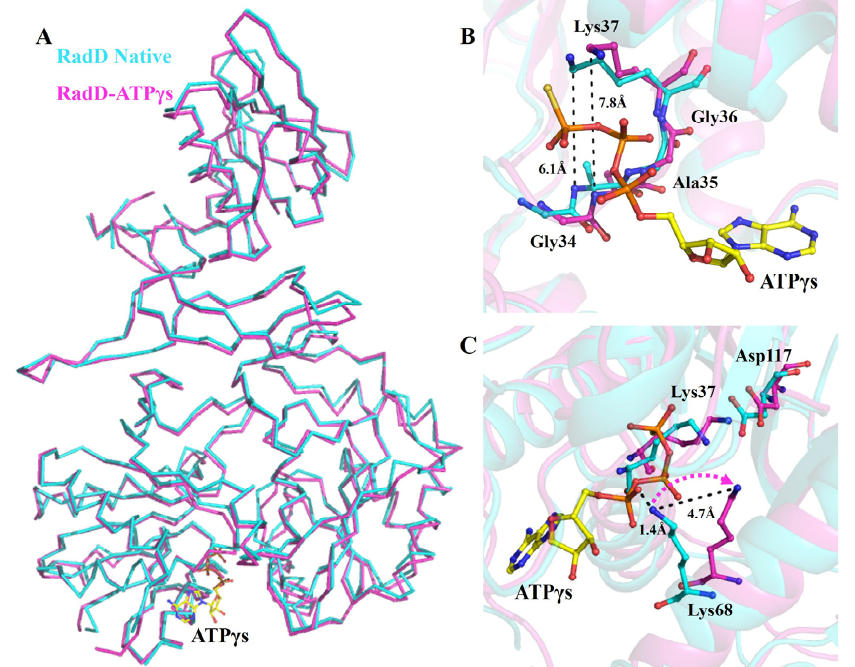
Figure 1. Conformation changes in RadD due to ATP binding. ( A ) Superposition of the structures of apo-RadD and RadD/ATP γ S, shown as ribbon. ( B ) Walker A motif expands slightly when RadD binds an ATP, shown as sticks. ( C ) Compared with the structure of apo-RadD, Lys68 shifts away due to the RadD binding the ATP molecule, shown as sticks. Apo-RadD is shown in cyan and RadD/ATP γ S in magenta.